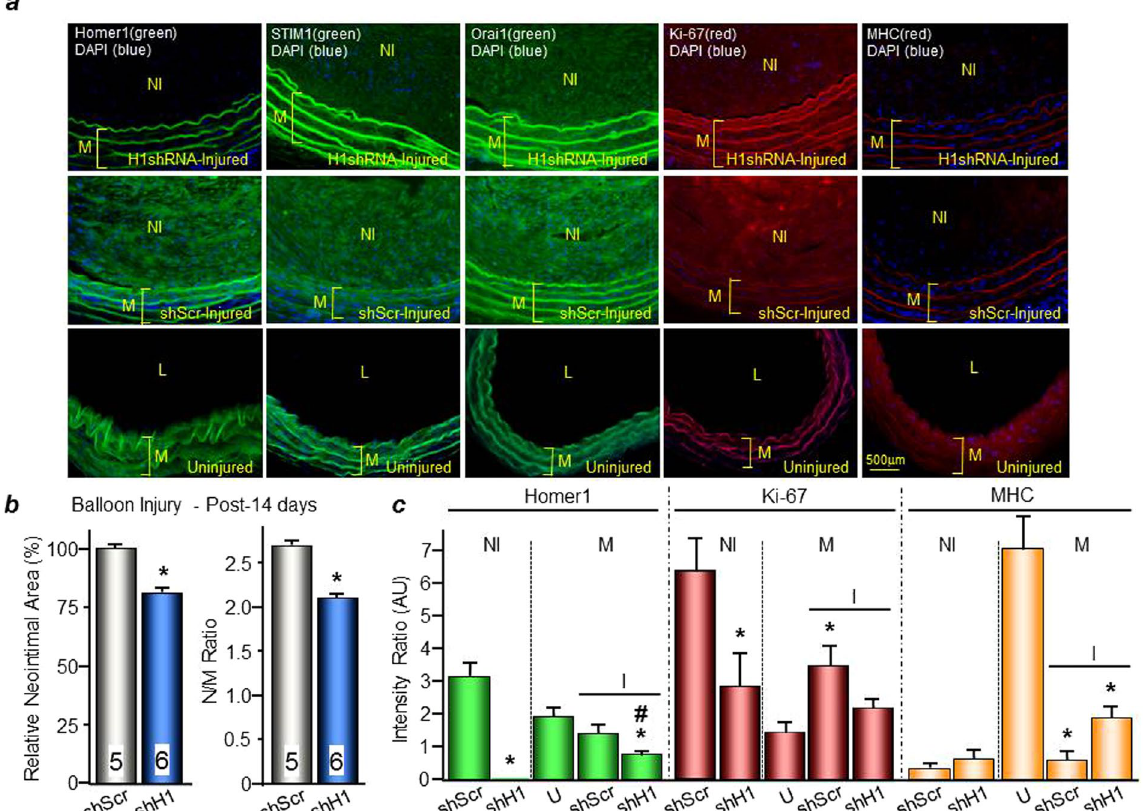
Figure 5. Effect of in vivo knockdown of Homer1 on neointima formation. Balloon-injured arteries were treated with AAV-shScrambled(-shScr) or AAV-shHomer1. ( a ) Representative immunofluorescence staining images of Homer1, STIM1, Orai1, Ki-67, and MHC with DAPI in injured (shScr- or shHomer1-treated) and uninjured arteries. ( b ) Quantification of neointimal area in shScr- and shHomer1-treated injured arteries. Neointima area in shScrambled (shScr)-treated arteries is set to 100%. * p < 0.05 or better compared to shScr. ( c ) Fluorescence Intensity Ratios of Homer1, Ki-67, and MHC. Intensities are normalized to DAPI (DNA fluorescence); AU, arbitrary units. * p < 0.05 or better compared to shScr or uninjured arteries in corresponding category (NI or M) and stain; # p < 0.05 compared to shScr in media. n = 5 for shScr-treated injured arteries; n = 6 for uninjured and shHomer1-treated injured arteries. NI = Neointima; M = Media; U = Uninjured; I =